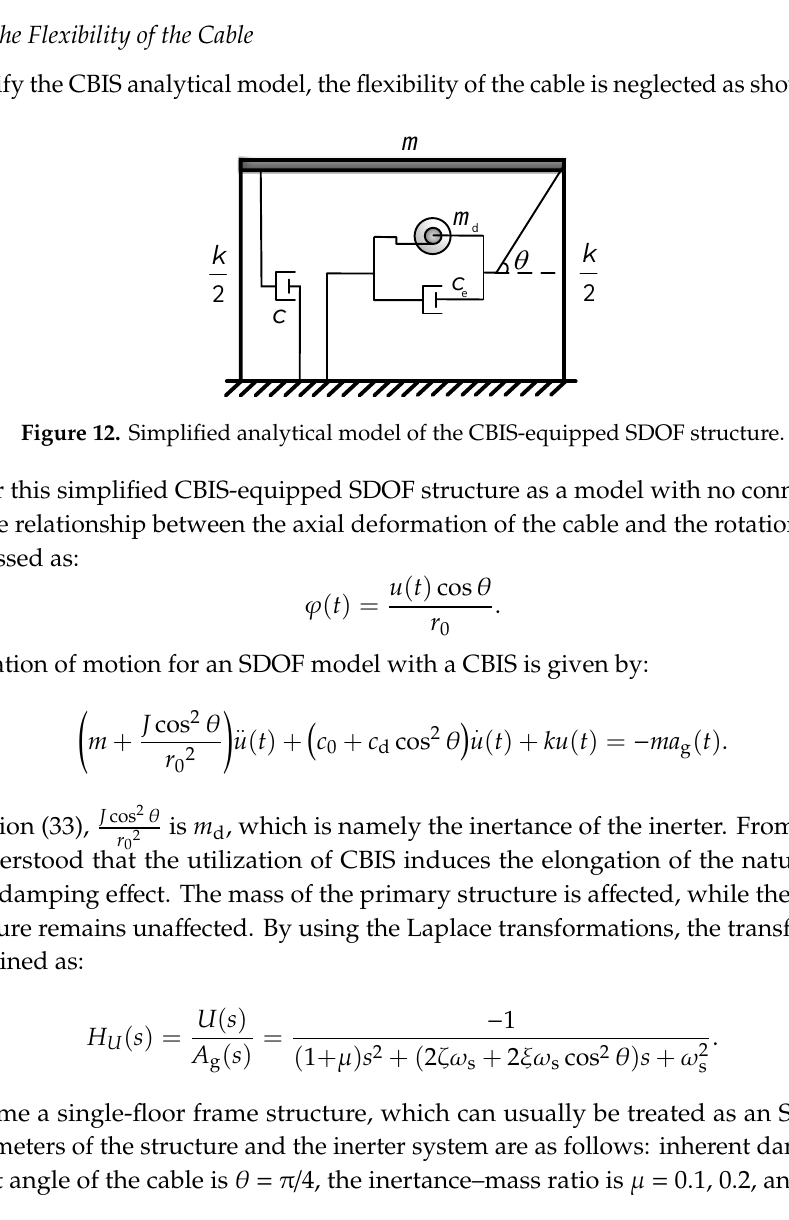
Table 3. Displacement responses at the roof of the test frame (m).